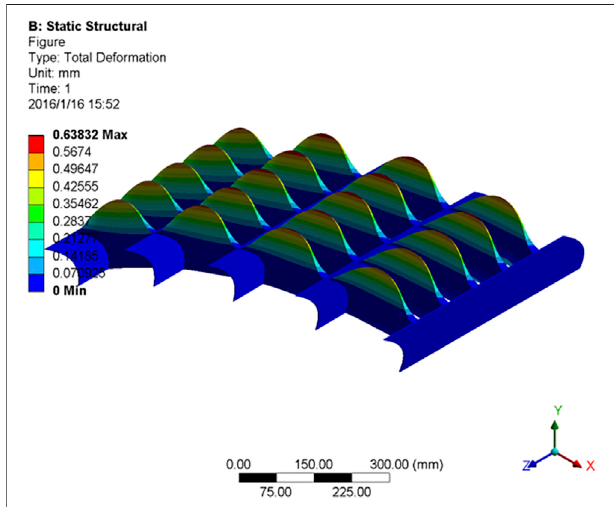
TABLE 9 | Decrease in maximum deformation due to increase in unit mass